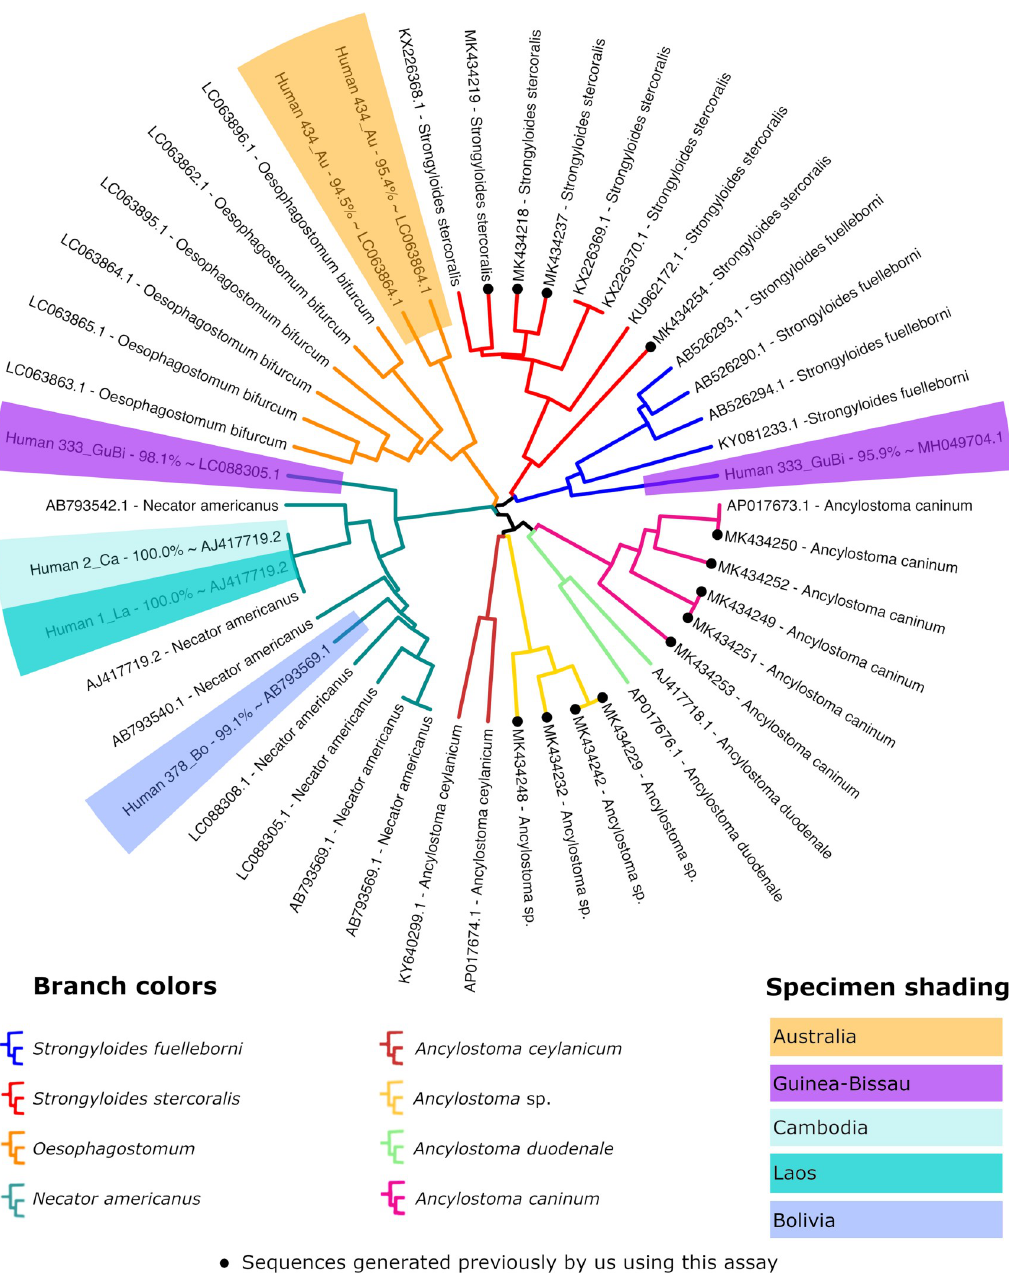
Fig 4. Dendrogram of cox1 sequences from Strongyloides spp. and hookworms. This figure demonstrates that the cox1 assay described here is broadly specific for Strongyloides spp. and some strongylids. Fragments of cox1 from Ancylostoma spp., Oesophogostomum and Necator americanus have been amplified and sequenced using this assay. Additionally, we previously detected cox1 sequences from Metastrongylus sp., a rotifer, and some unknown nematodes using this approach [21]. The sequences generated in this study are shaded in colors according to their country of origin and those generated by us in a previous study are marked with a black dot on the associated branch tip. The sequences used to construct this dendrogram are included in S3 File. This figure incorporates the corrections detailed in Table